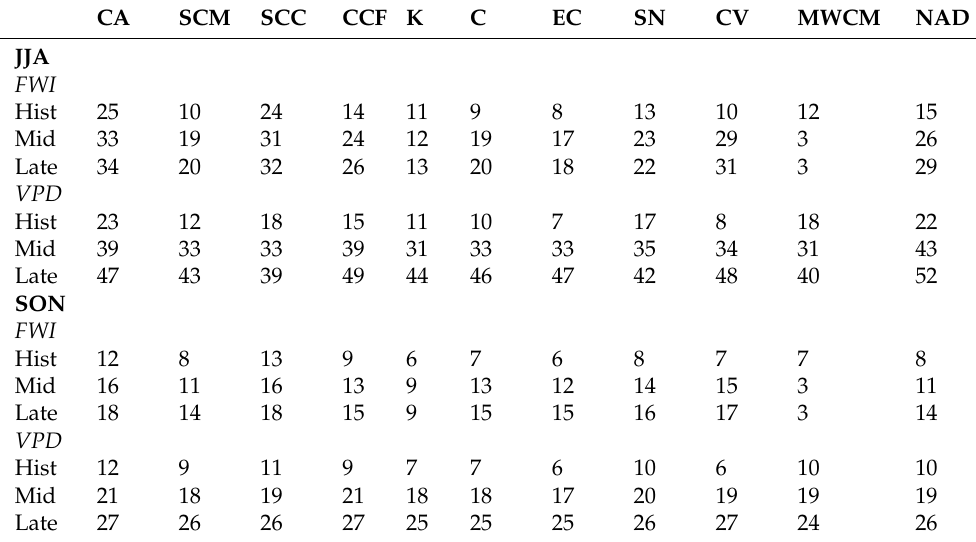
Table 2. Ecoregion average number of VPD 95 and FWI 95 days per year in each time period.